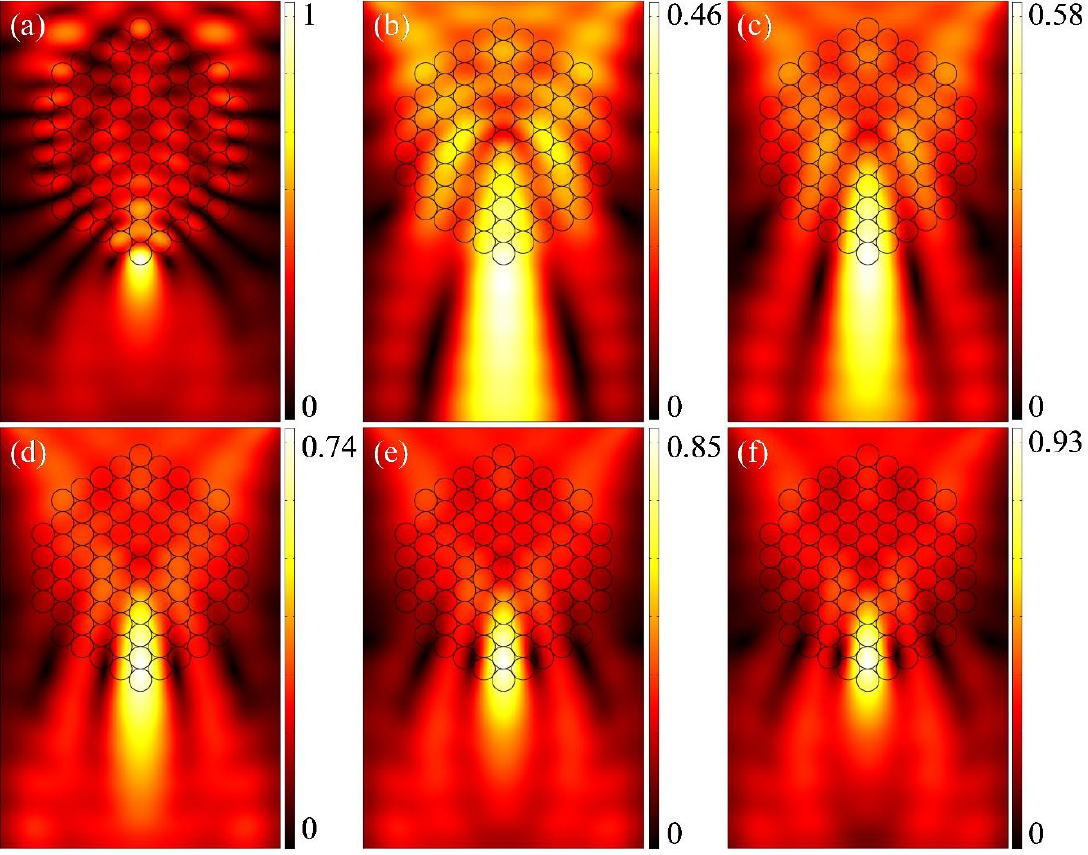
Figure 3. Spatial intensity distributions of photonic nanojets formed in the vicinity of cylindrical graded-index lens with ( a ) homogeneous material ( n = 1.5), ( b ) t = 0.2, ( c ) t = 0.5, ( d ) t = 1, ( e ) t = 1.5, and ( f ) t = 2.